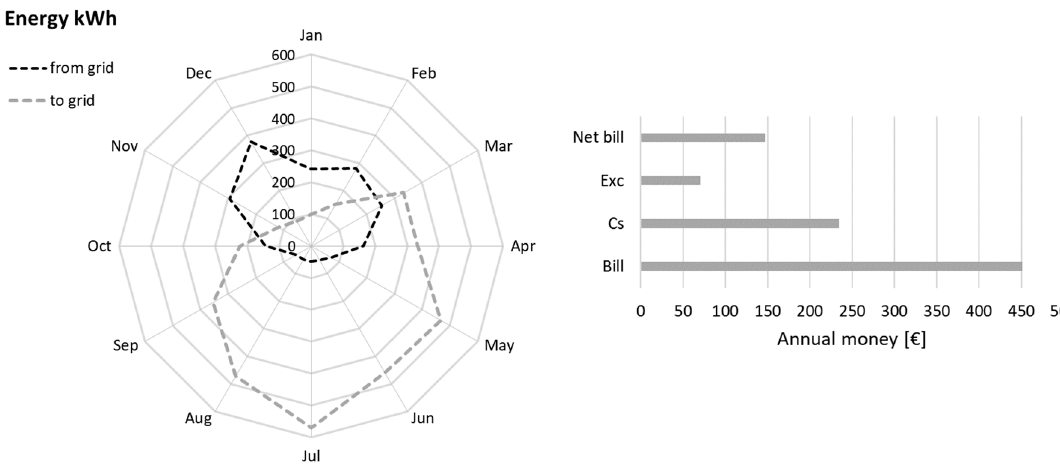
Figure 3. Reference case: monthly energy exchanges with the grid and annual bills/takings for the householder with net-metering (Equations (1)–(3)).